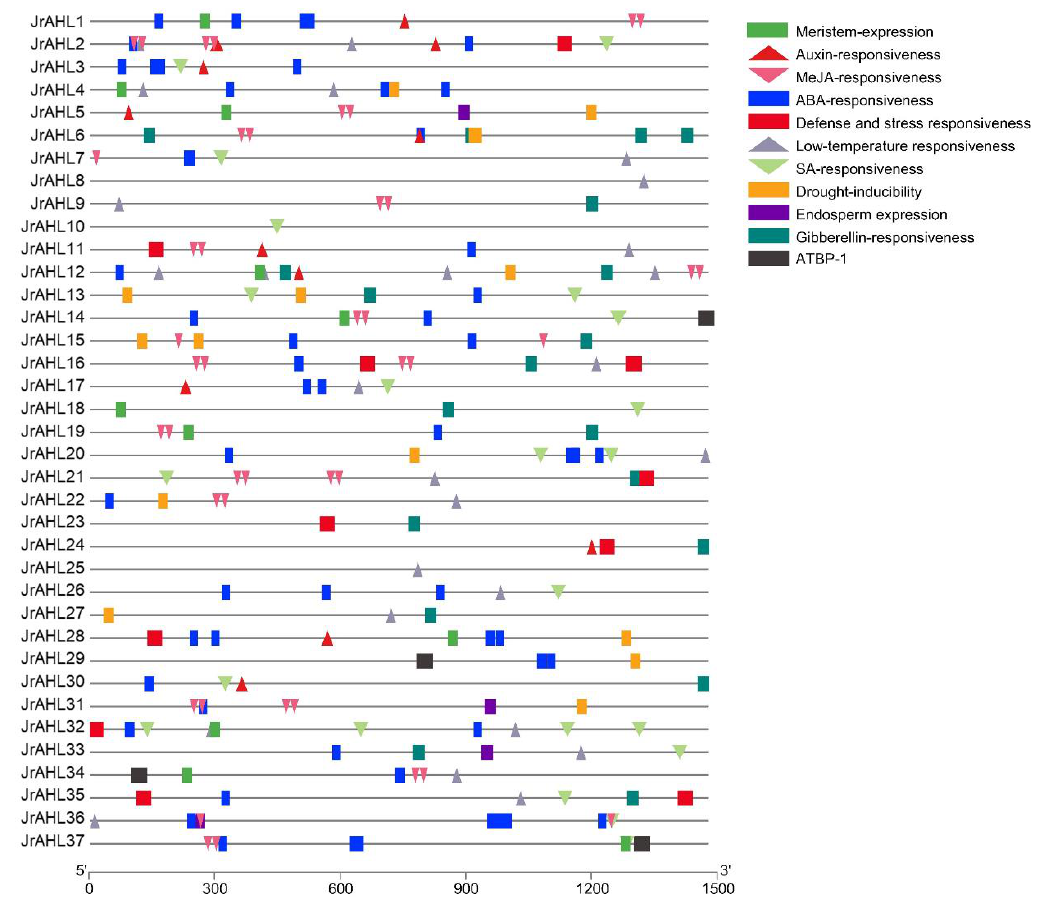
Figure 5. Predicted cis -elements in the JrAHL promoters. The 1.5-kb sequence upstream from the start codon of JrAHL genes was analyzed using the PlantCARE database. Different colored graphics represent different cis -acting elements.